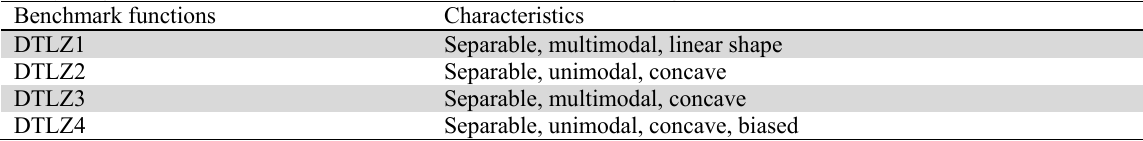
Many-objective benchmark functions characteristics (Zhang et al., 2016) Benchmark functions Characteristics DTLZ1 Separable, multimodal, linear shape DTLZ2 Separable, unimodal, concave DTLZ3 Separable, multimodal, concave DTLZ4 Separable, unimodal, concave,